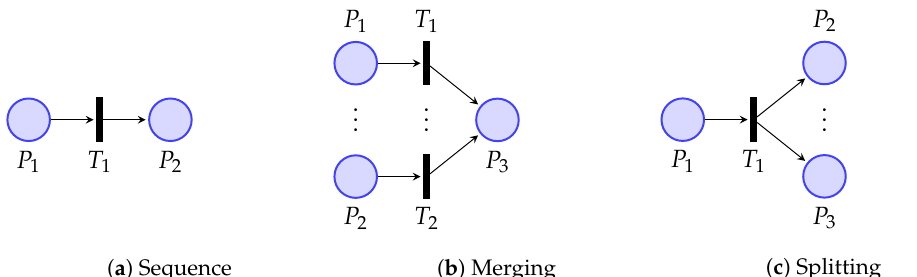
Figure 1. Elementary Petri Net structures in which the transitions can be assigned to the set of independent transitions T I .